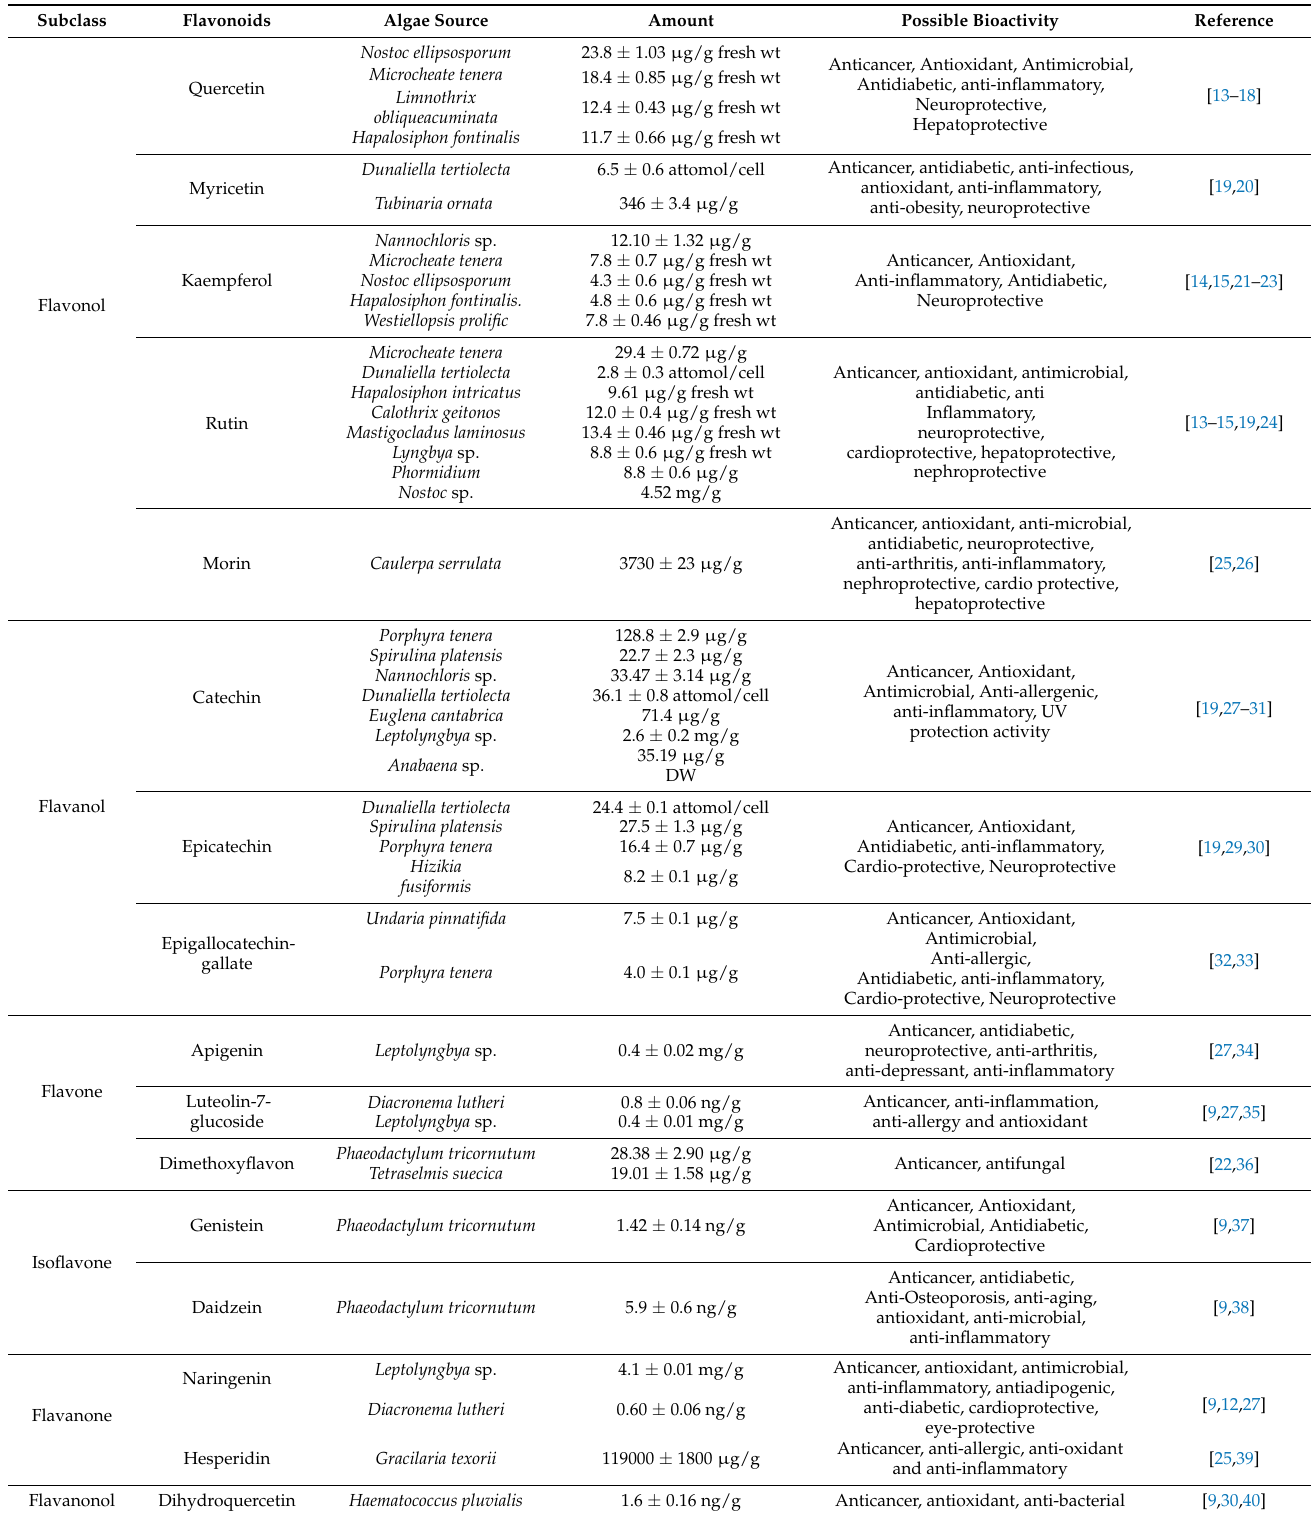
Table 1. Sources of algal flavonoids and their possible anticancer